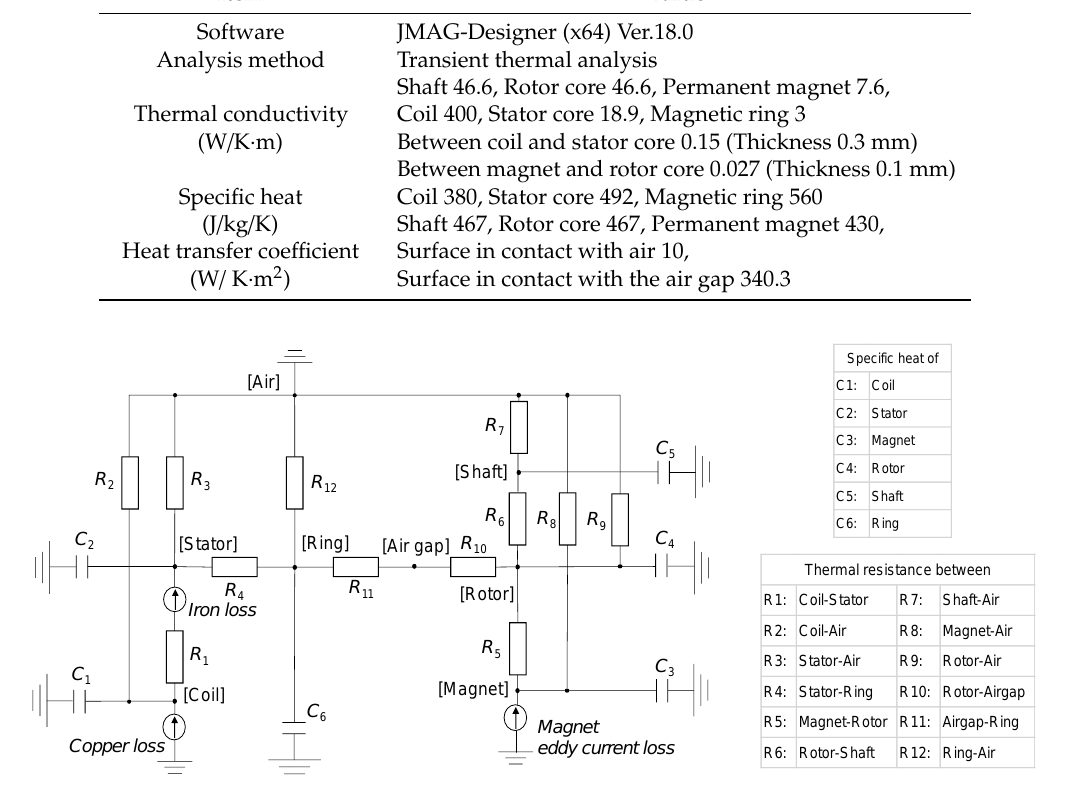
Figure 4. Simulation motor thermal circuit. Table 4. Thermal characteristic parameters.